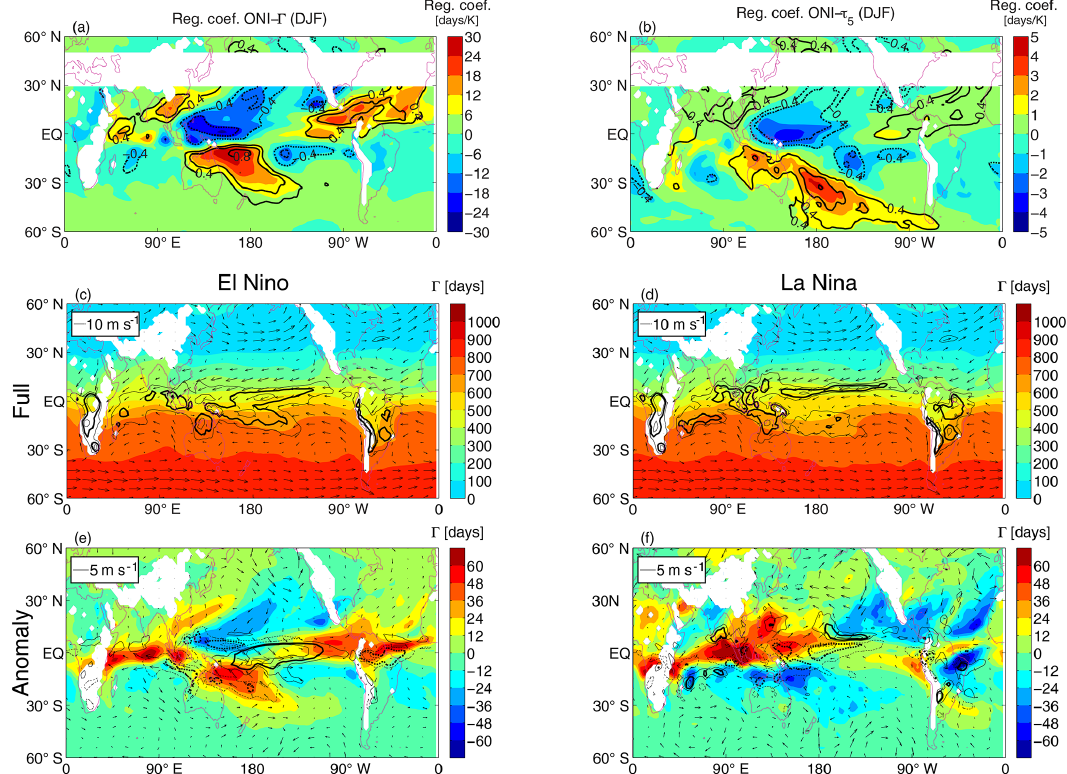
Figure 9. Relationships between tracer ages and ENSO. (a) Regression coefficients (shading) and correlation coefficients (contours) between (cid:48) at 900hPa and ONI for DJF. Correlations with absolute value larger than 0.361 are significant at 95% confidence level. (b) As in (a) but for τ 5 at 900hPa. (c, d) (cid:48) (shading), 900hPa horizonal winds (arrows) and precipitation (contours; (4, 6, 8) mmday − 1 , with the 6 mmday − 1 bold) for composites of (c) El Niño winters and (d) La Niña winters. (e, f) As in panels (c, d) but showing the anomaly from climatological DJF fields. In panel (e) black contours show precipitation anomalies of (4, 6, 8) mmday − 1 , and gray contours show precipitation anomalies of ( − 8, − 6, − 4) mmday − 1 while in panel (f) black contours show precipitation anomalies of (2, 3, 4) mmday − 1 , and gray contours show precipitation anomalies of ( − 4, − 3, − 2) mmday − 1